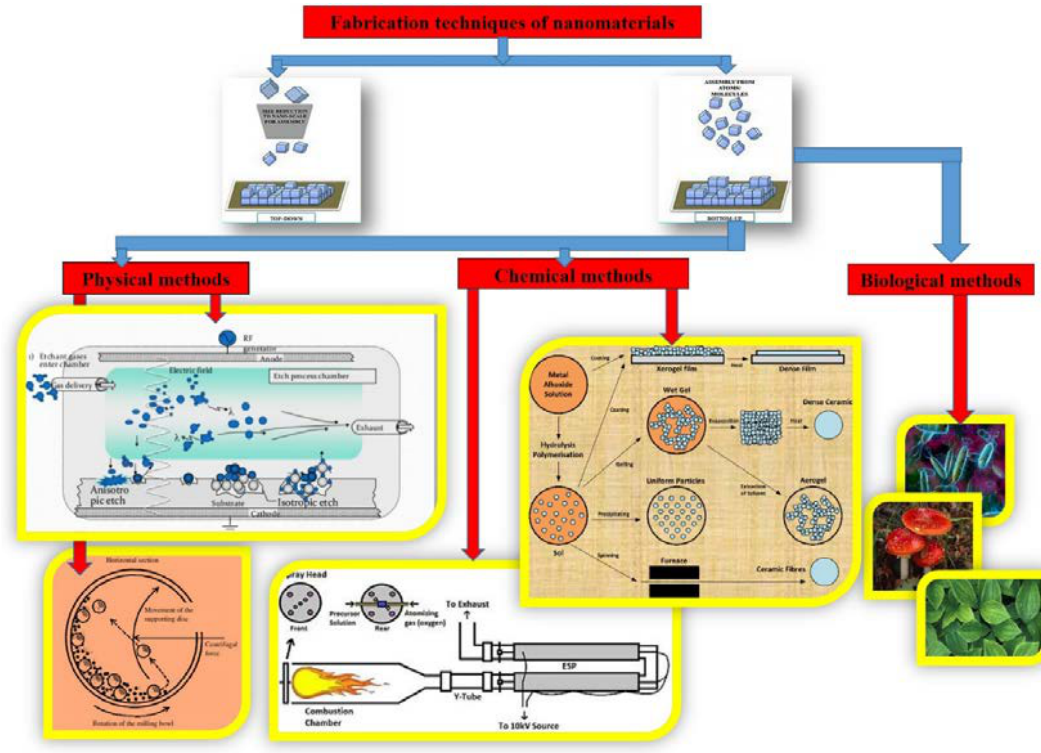
Fig. 1: Fabrication techniques of